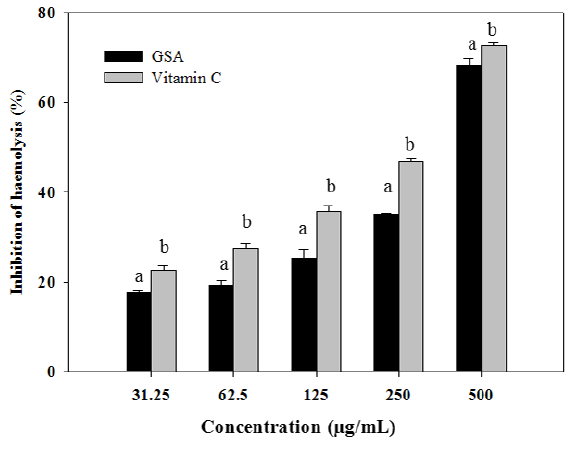
Figure 1. Anti- haemolytic activity of GSA on APPH-induced erythrocyte haemolysis in vitro . Data are expressed as mean ± SD ( n = 3). Columns with different letters are significantly different at p < 0.05